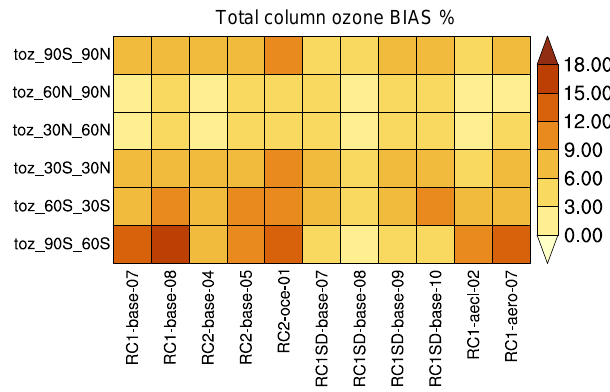
Figure 26. Mean total column ozone bias (in %) between the sim- ulations and the reference data set BSTCO for different latitude bands. The analyses are based on annual means of the years 1980 to 2011. The only exception is RC1-aero-07, which starts